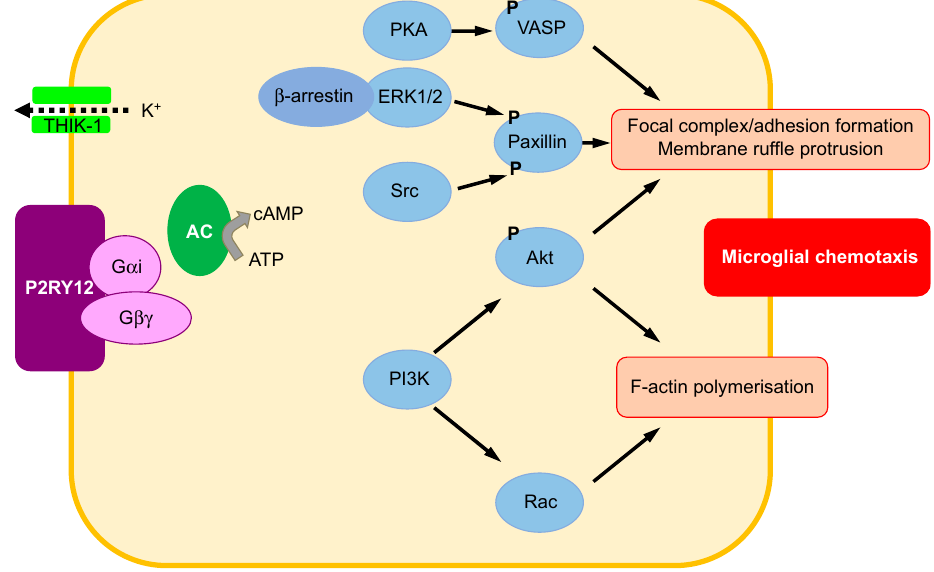
Figure 3. Major signal pathways involved in microglial motility and migration after P2RY12 acti- vation. (1) Once released from G α i, G βγ activates adenylate cyclase (AC), which induces cyclic adenosine monophosphate (cAMP) increase, phosphorylation of vasodilator-stimulated phospho- protein (VASP) by protein kinase A (PKA), and then membrane ruffle formation and chemotaxis via the regulation of focal adhesion formation/maturation. (2) The recruitment of β -arrestin recruits and activates extracellular signal-regulated kinase (ERK) 1/2, inducing paxillin phosphorylation which is necessary for adhesion disassembly during chemotaxis. (3) The activation of Src through G α i triggers the phosphorylation of paxillin, which is essential to focal adhesion assembly. (4) G α i and G βγ activate phosphoinositide 3-kinase (PI3K), promoting Akt (=protein kinase B) and Rac activation that are both involved in F-actin polymerization. (5) P2RY12 activation potentiates the activity of TWIK-related halothane-inhibited K+ channel (THIK-1) involved in microglial ramification regulation and surveillance of healthy